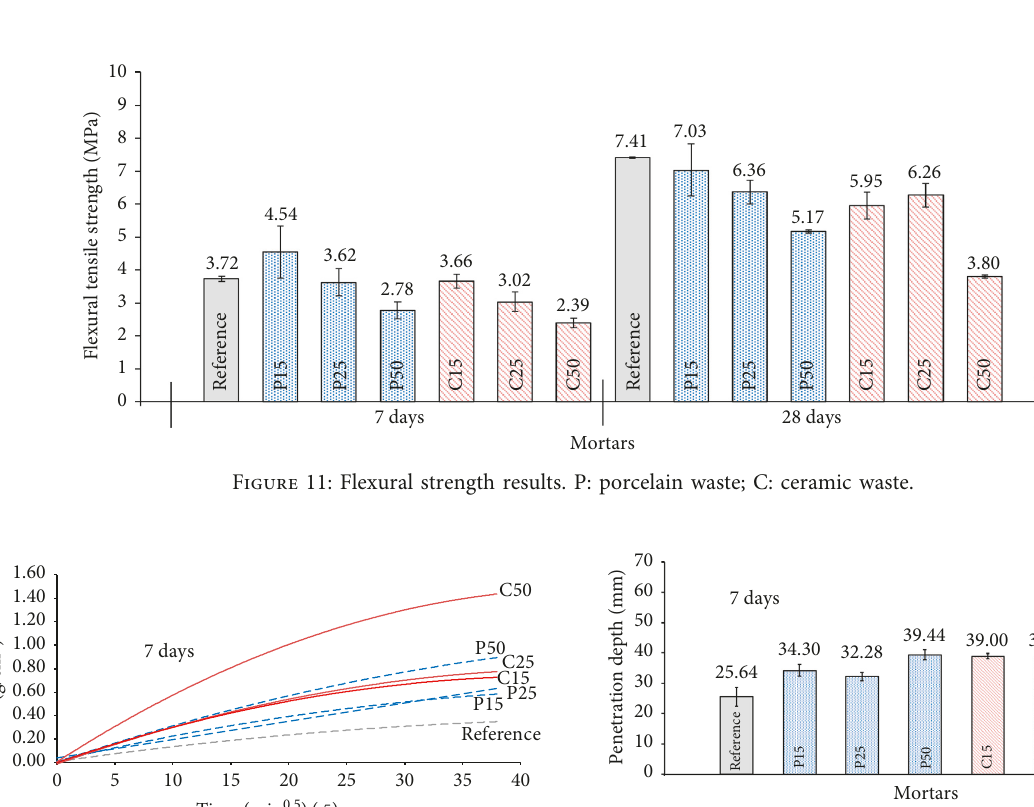
Figure 13: Water penetration depth results. P: porcelain waste; C: ceramic